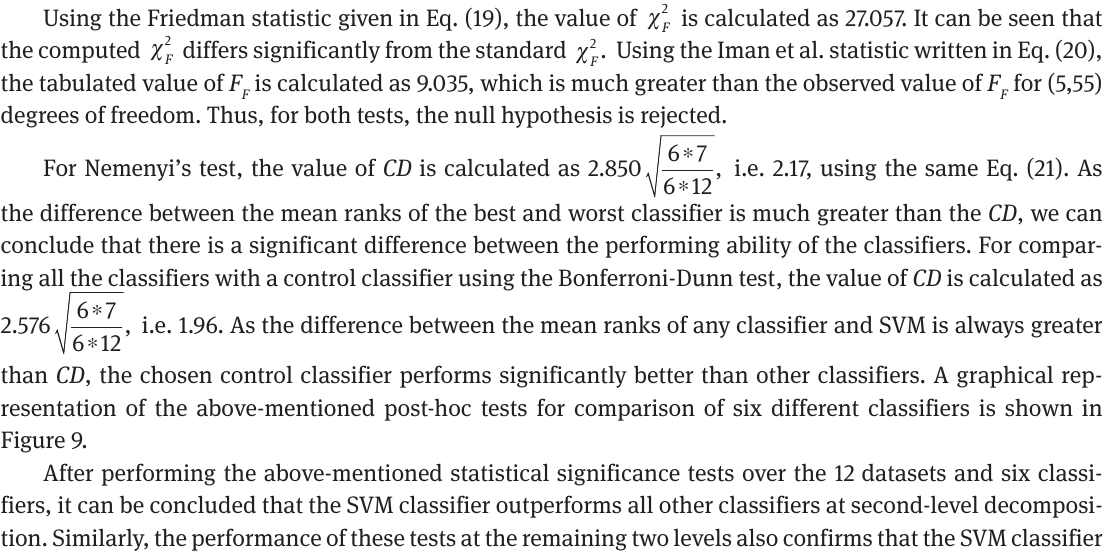
Table 4: Recognition Accuracies of Six Classifiers and Their Corresponding Ranks Using 12 Different Datasets after Applying HSA (Ranks in Parentheses Are Used for Performing Friedman Test).